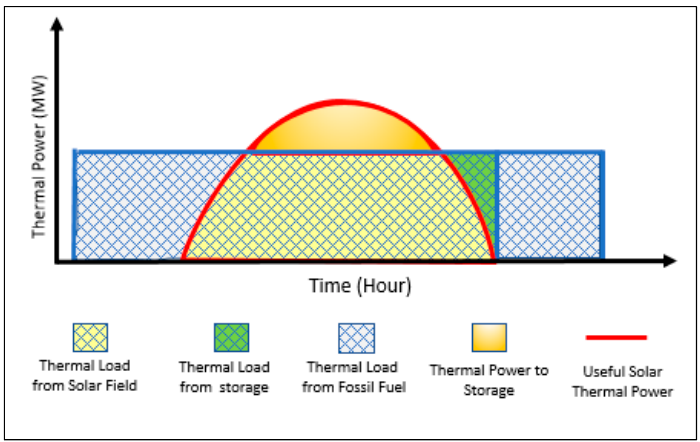
Figure 6. Optimal thermal power mix for the MED plant and the entire system with 80% RO 20% MED .